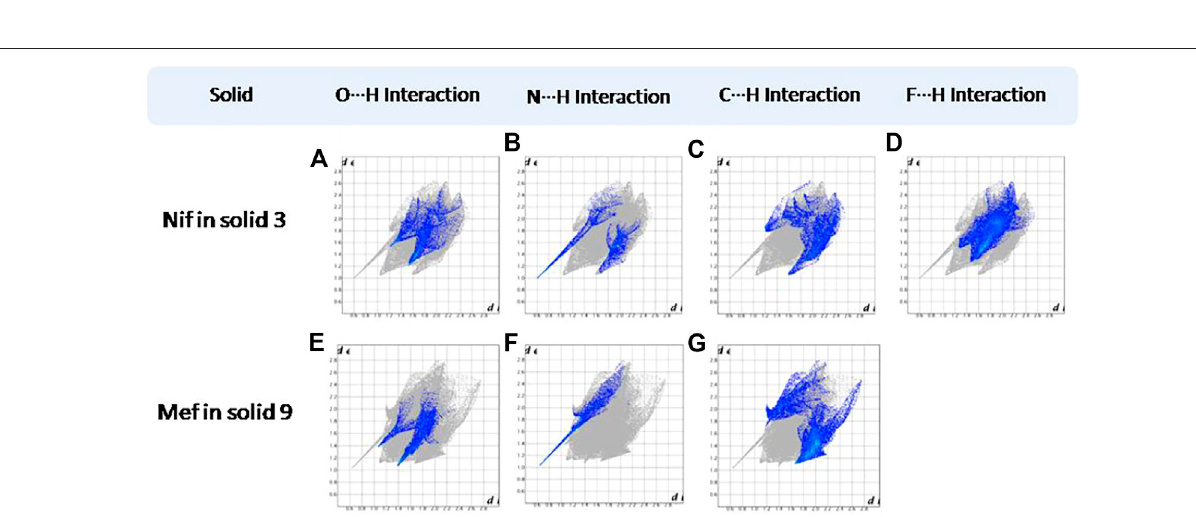
Frontiers in Chemistry |